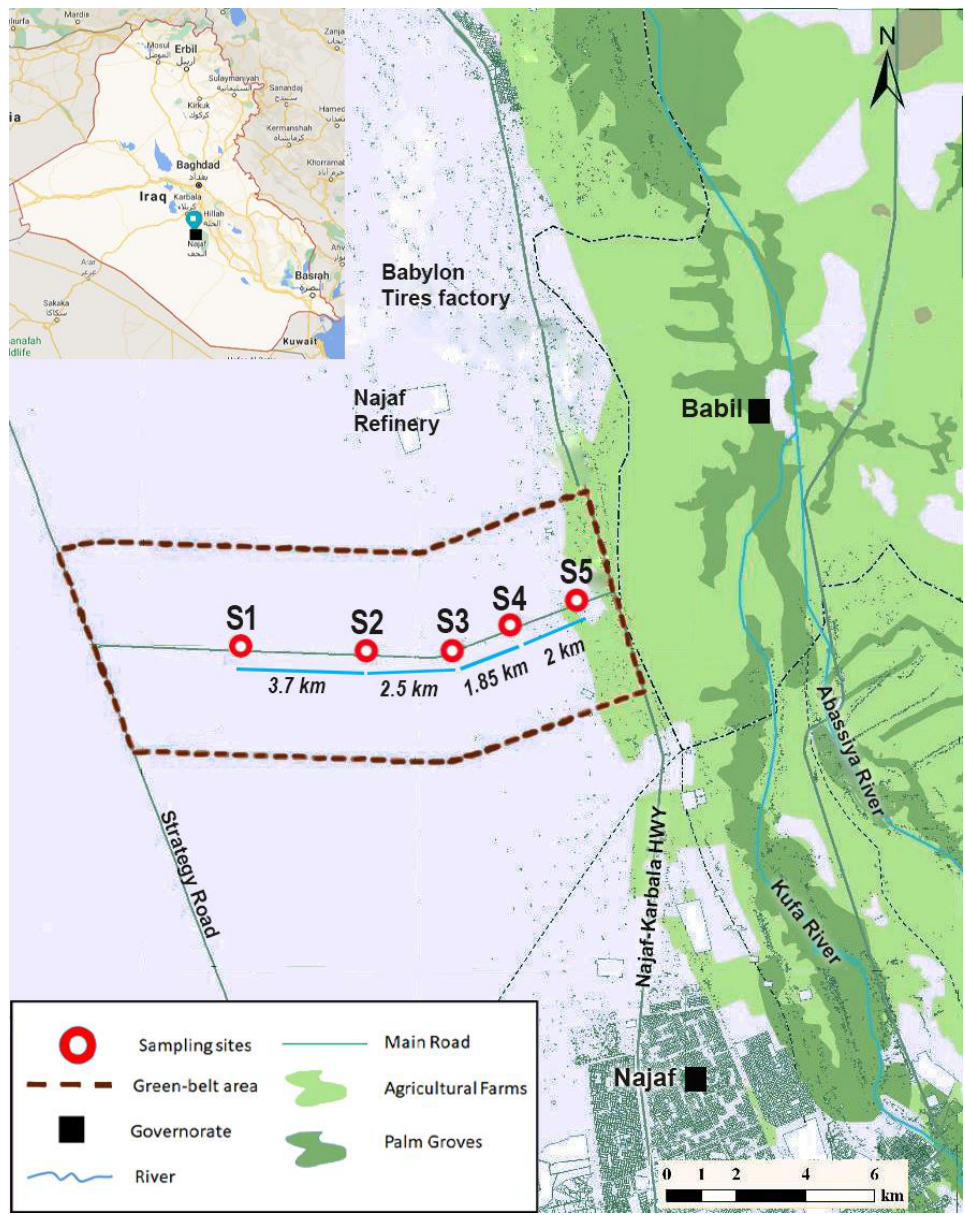
Figure 1. The groundwater-sampling sites at the Greenbelt area, northwestern Al-Najaf Gover- norate, Iraq.